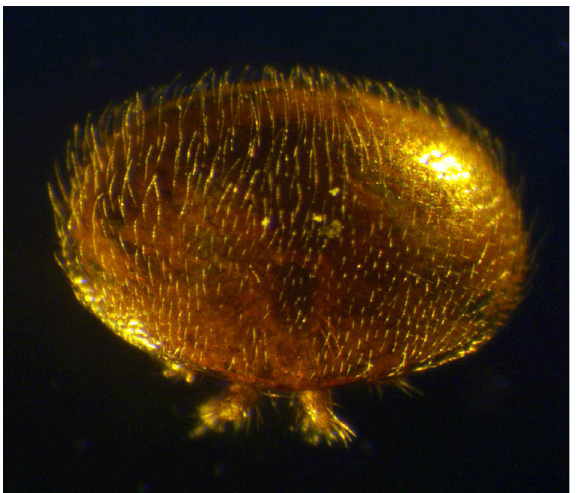
Fig 6. Adult female Varroa destructor showing the covering of fine hairs that may prevent RNAlater entering the